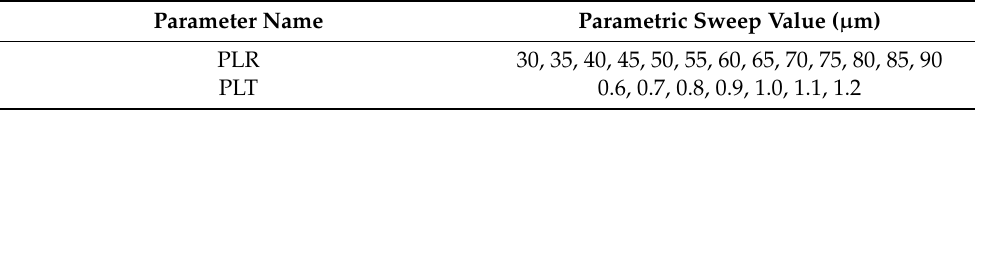
Table 2. Parametric sweep